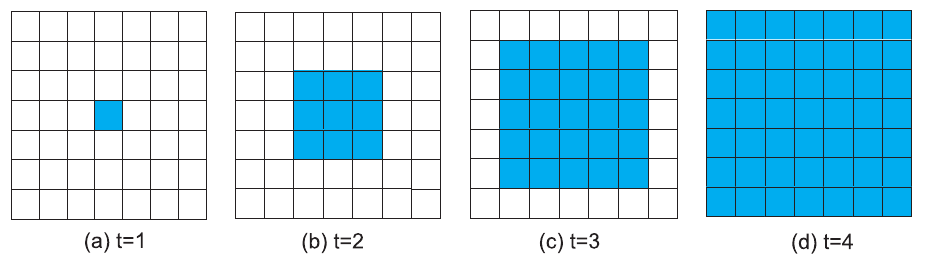
Figure 9. (Color online) Time evolution of defector-invasion on a 7 | 7 square lattice with 8-player neighborhood. Initially, there is one defector (the green square in figure(a)) and forty-six cooperators (the forty-six blank squares). If R w 8 M = 11 , the defectors occupy all the squares in the stationary state ( t ~ 4 , figure (d)).